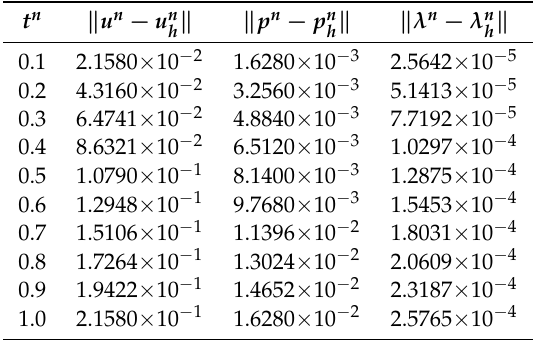
Table 6. Discrete errors with time steps for Example 2, nb = 4, h = 1/64, δ t = 0.1.